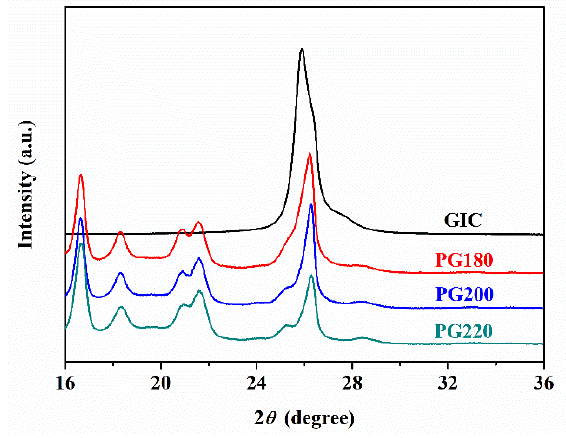
Figure 2. WAXD spectra of GIC, PG180, PG200, and PG220 samples.